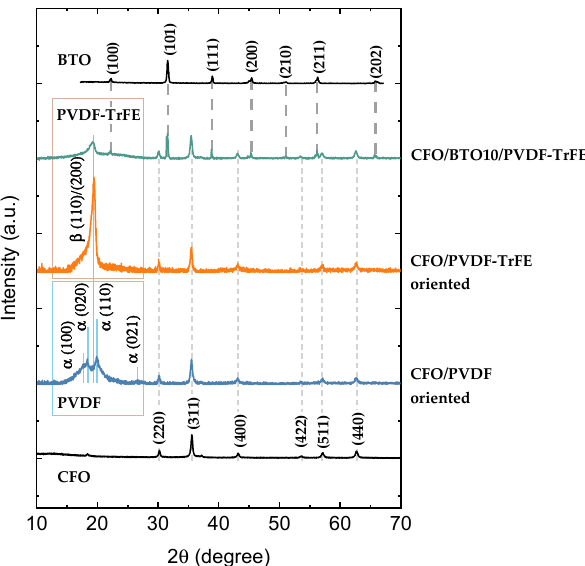
Figure 3. XRD patterns of CFO and BTO nanoparticles, CFO/PVDF, CFO/PVDF-TrFE, and CFO/BTO10/PVDF-TrFE nanocomposites. The Miller indexes specified for pure CFO, BTO particles and PVDF (PVDF-TrFE) polymer are guided to corresponding reflections in composites via dashed lines.